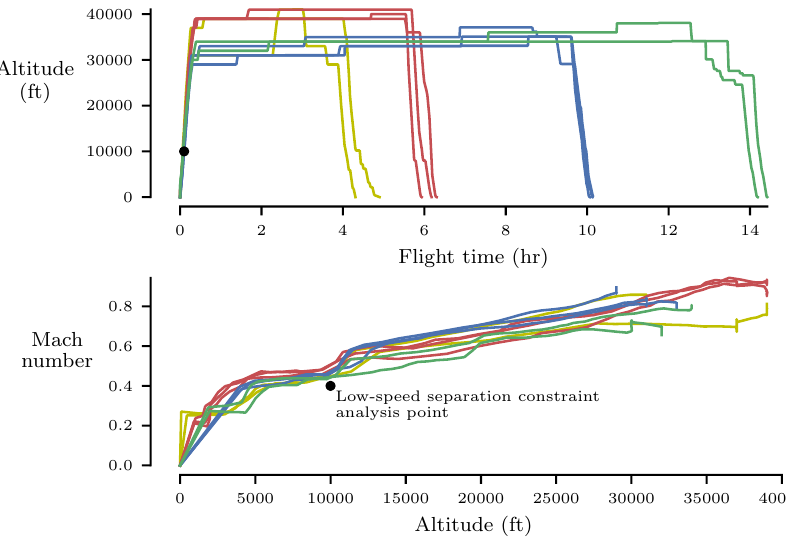
Figure 7. Analysis point for low-speed, high-lift separation constraint is placed at the boundary of the climb profile for the Boeing